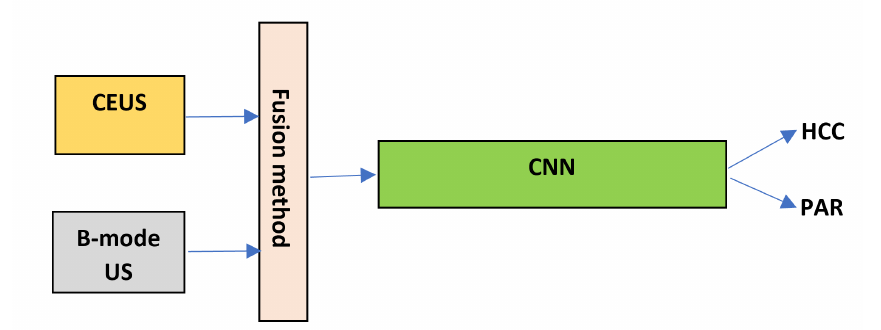
Figure 3. Feature level